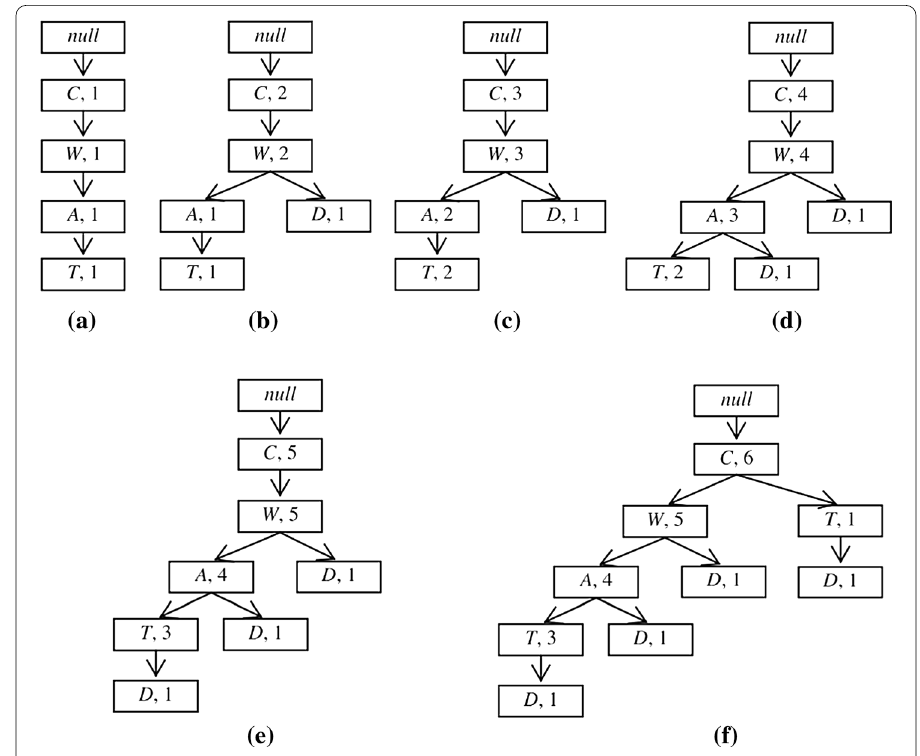
Fig. 4 Illustration of PPC tree creation using DB example with minSup